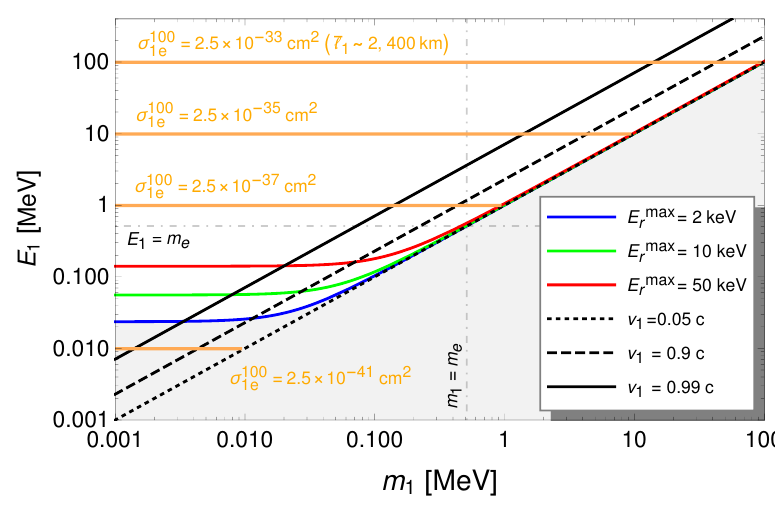
Figure 1 . Maximum recoil energy of electrons scattered off by BDM, E max